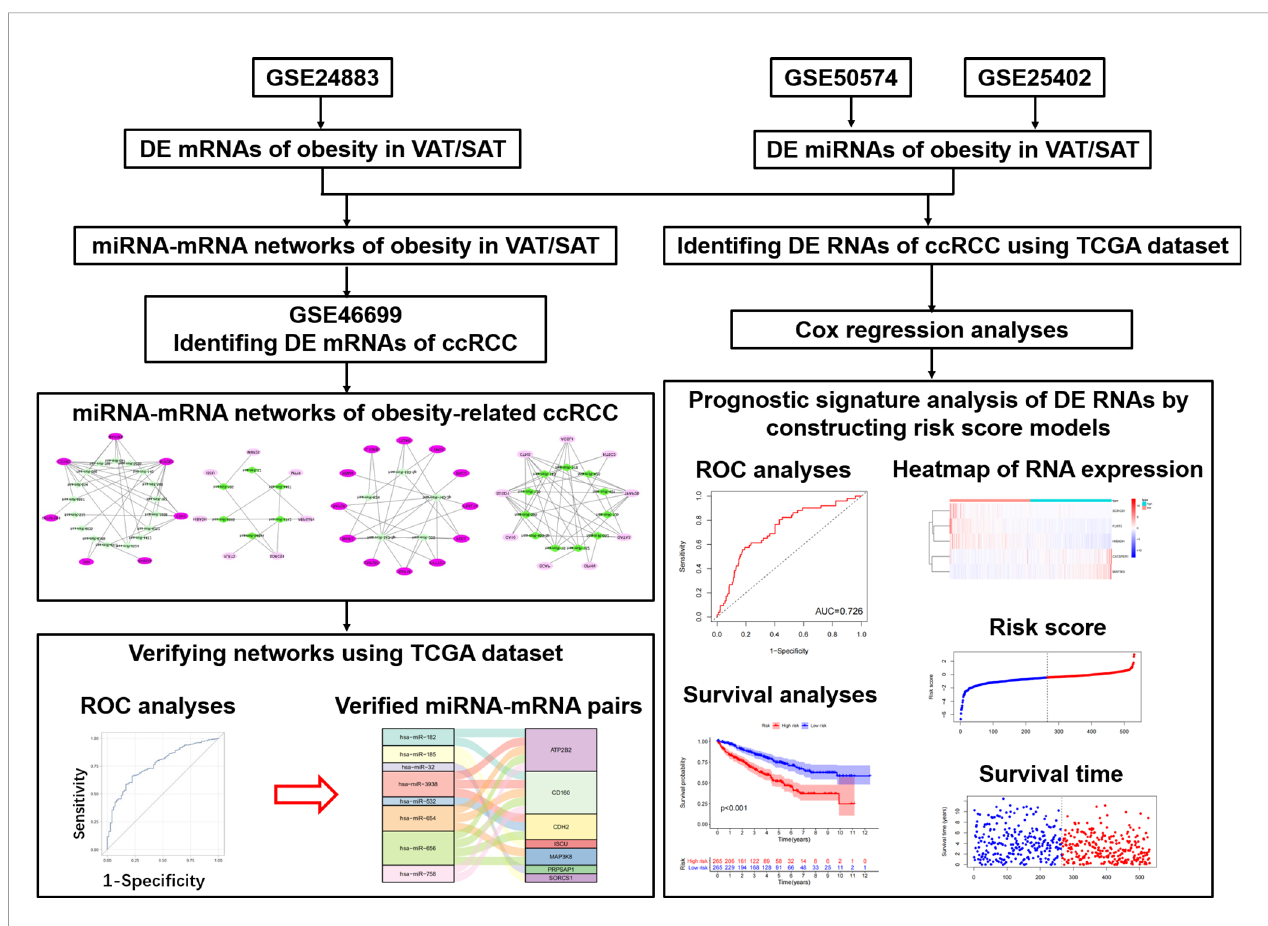
FIGURE 1 | Flow chart of this